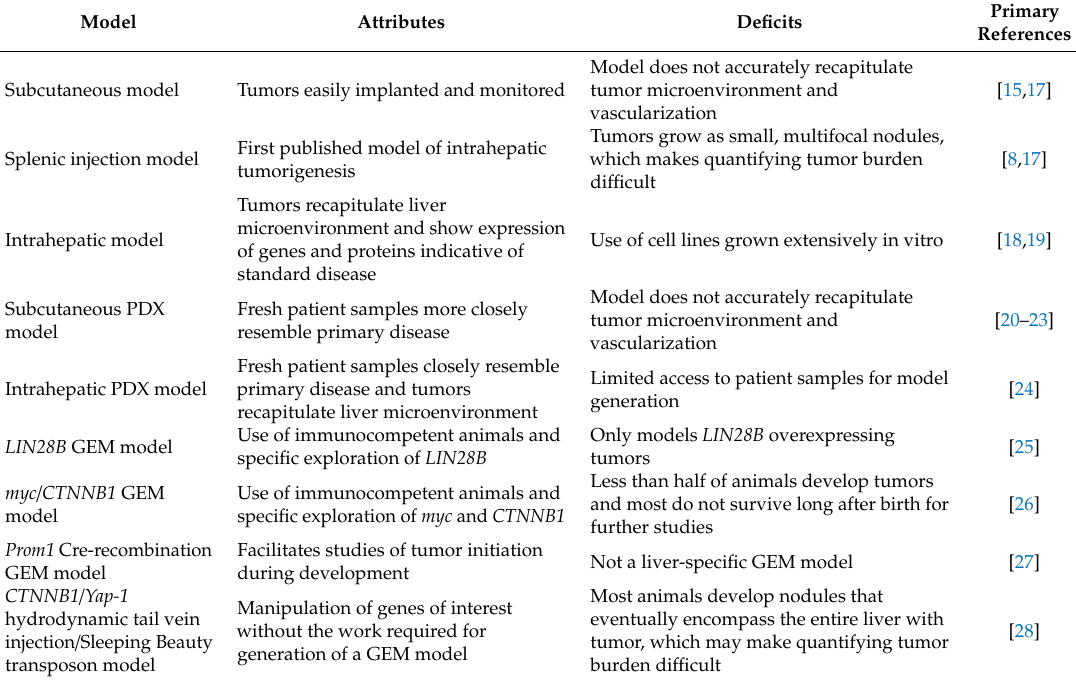
Table 1. Major murine models of